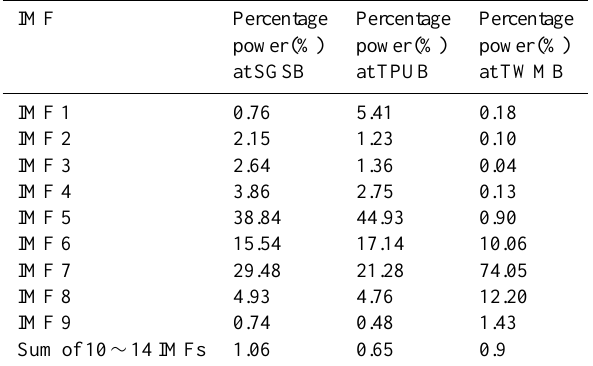
Table 2. The percentage powers of the IMFs at the SGSB, TPUB, and TWMB stations.